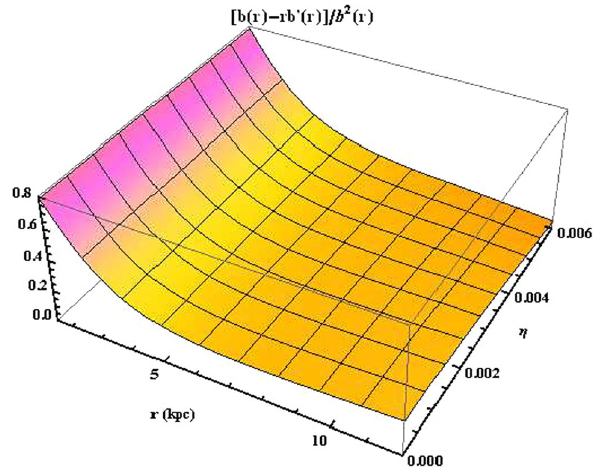
Fig. 4 The function [ b ( r ) − rb (cid:2) ( r ) ] / b 2 ( r ) is plotted with respect to the radial coordinate r corresponding to the parameters ρ 0 = 0 . 004 kpc − 2 , α = 0 . 5 , β = 0 . 8 , r th = 1 kpc and r 0 = 2